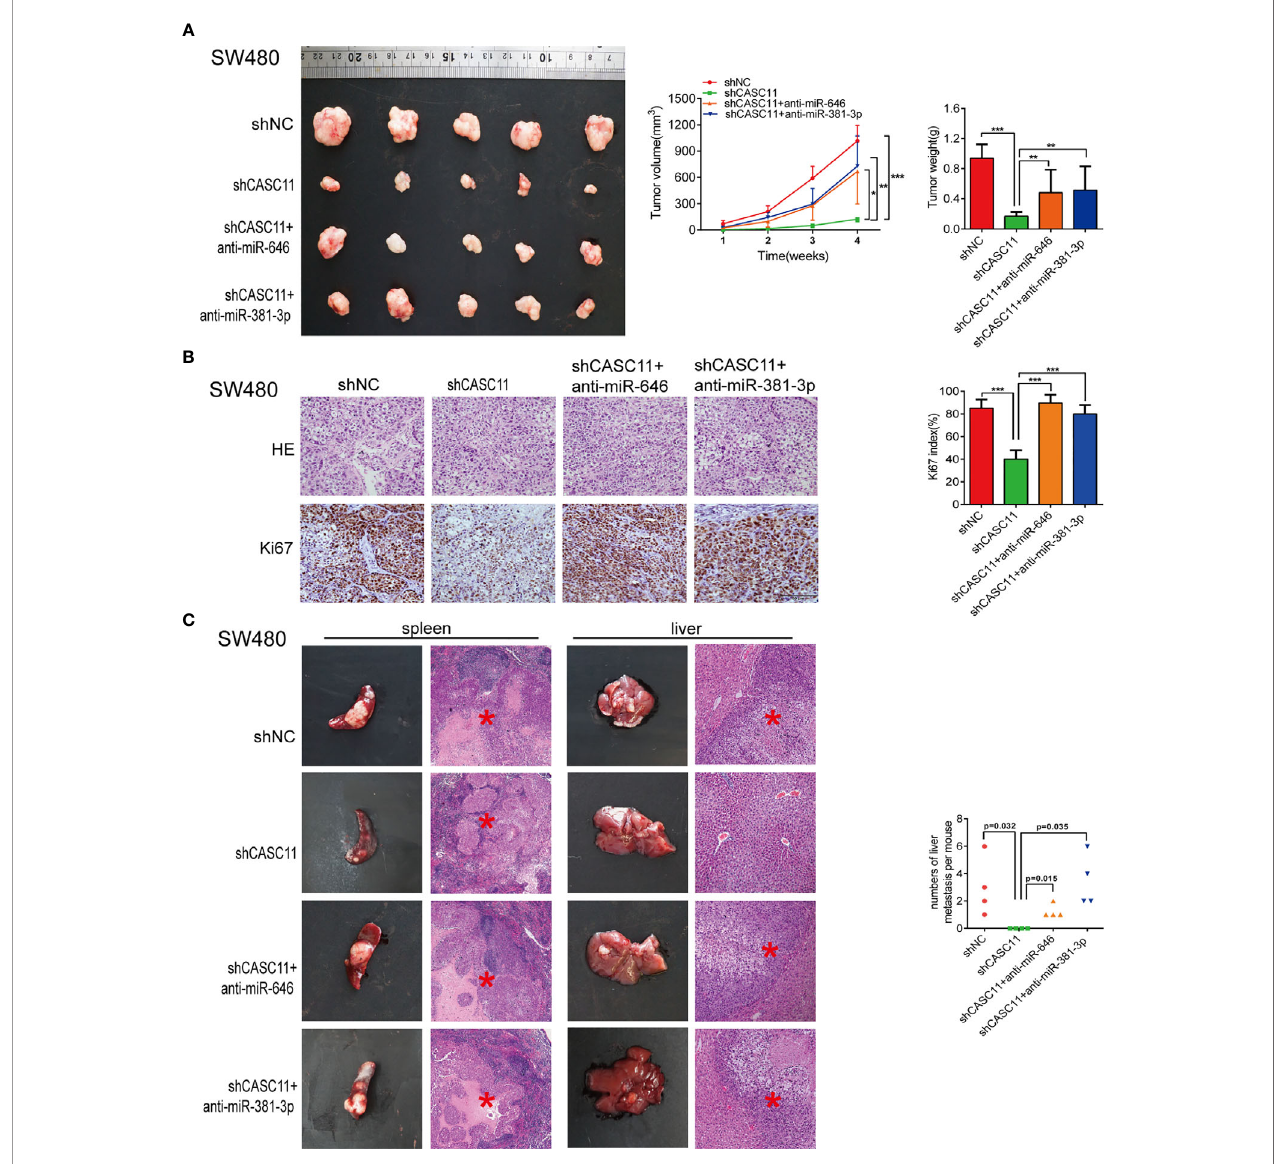
FIGURE 3 | miR-646 and miR-381-3p inhibitors reverse CASC11 interference -mediated phenotypes of CRC cell proliferation and migration in vivo . (A) Mouse models of subcutaneous tumours developed from CASC11-knockdown SW480 cells, which were treated with anti-miR-646 or anti-miR-381-3p (n=5). Left: Images of the tumour mass of each group at the endpoint of the experiment. Middle: tumour growth curves. The data were calculated as the mean tumour volumes ± SD for 5 samples. Right: Tumour weights of the xenografts upon euthanasia at day 28. (B) Representative images of Ki67-positive sections of subcutaneous tumours by IHC assay. The error bars in all graphs represent the means ± SD of 3 different fi elds. (C) Representative images of splenic tumours, hepatic metastases, and haematoxylin and eosin (H&E) staining. The numbers of hepatic metastases per mouse are indicated on the right side (n = 4). * p < 0.05; ** p < 0.01; *** p <